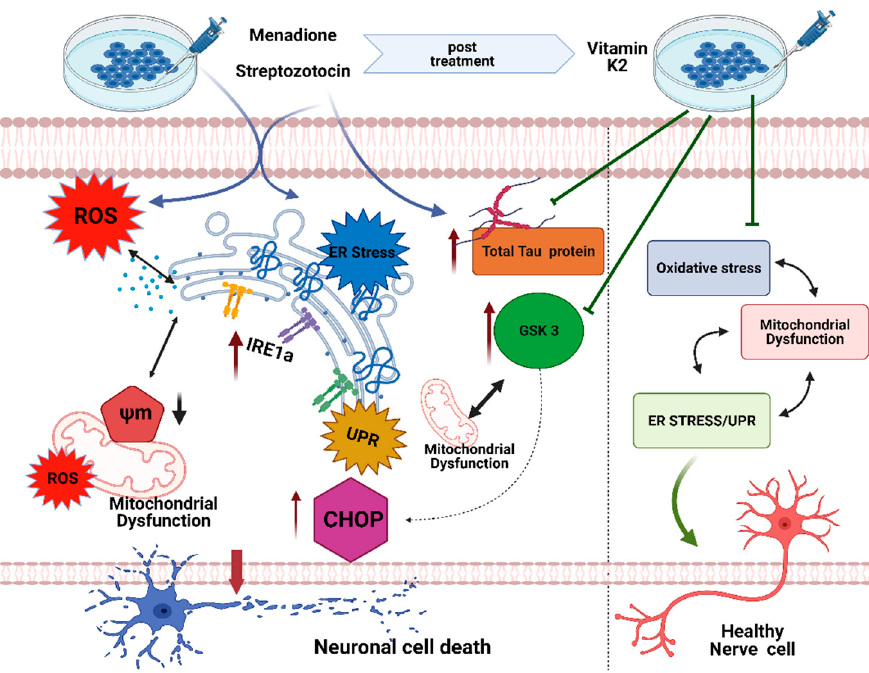
Figure 10. Schematic representation of the protective role of vitamin K2 in streptozotocin- and menadione-induced cytotoxicity in SH-SY5Y cells. Streptozotocin and menadione triggered reactive oxygen species (ROS), which in turn led to mitochondrial depolarization (reduction in mitochondrial membrane potential) and further activated endoplasmic reticulum stress as indicated by the increased expression of CHOP and p-IRE1 α . Upregulated CHOP expression is an indication of an increase in proapoptotic signals. Similarly an increase in p-IRE1 α level indicated induction of unfolded protein response, which might also result in the induction of proapoptotic signals during prolonged ER stress. Streptozotocin and menadione increased the GSK3 levels, which might be responsible for neuronal cell death by an increase in CHOP expression and mitochondrial dysfunction. In addition to this, streptozotocin treatment also increased the levels of intracellular total tau protein, while menadione was found to have no effect. However, post-treatment of vitamin K2 regulated the neuronal cell death signaling not only by improving mitochondrial health but also by inhibiting ER stress, decreasing the levels of GSK3, and inhibiting the increase in levels of total tau protein. (ROS—reactive oxygen species; ER—endoplasmic reticulum; UPR— unfolded protein response; GSK3—glycogen synthase kinase 3; IRE1—inositol-requiring enzyme; CHOP—C/EBP homologous protein; Ψ m—mitochondrial membrane potential.)